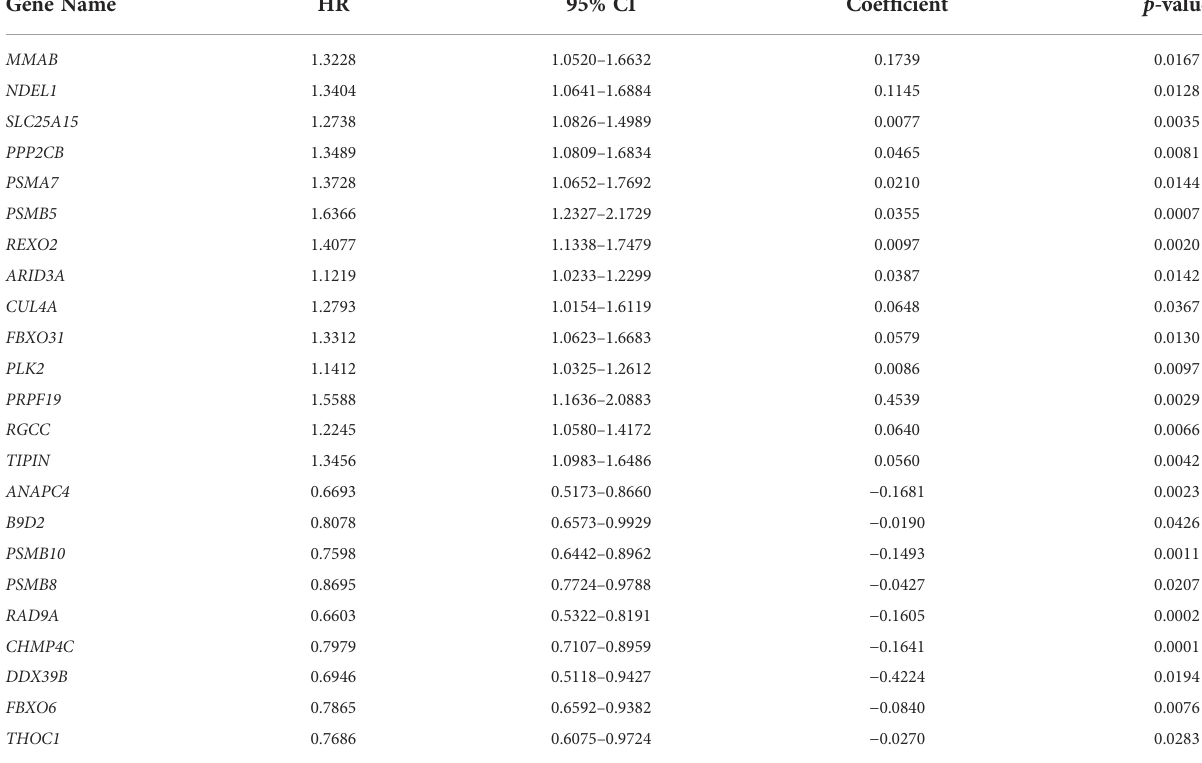
TABLE 2 The identi fi ed 23 genes involved in the prognostic CRG signature.